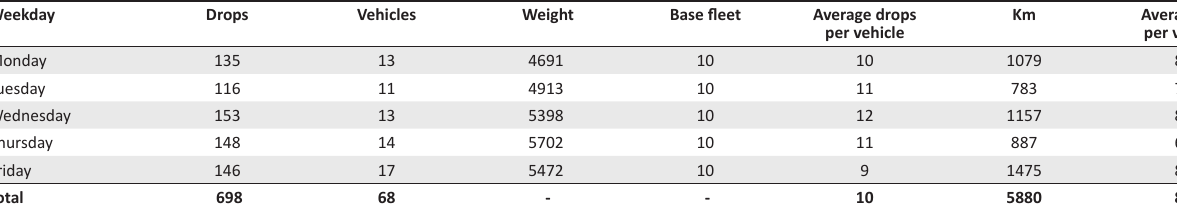
TABLE 6: Distribution centre 2 plan case study optimisation results.